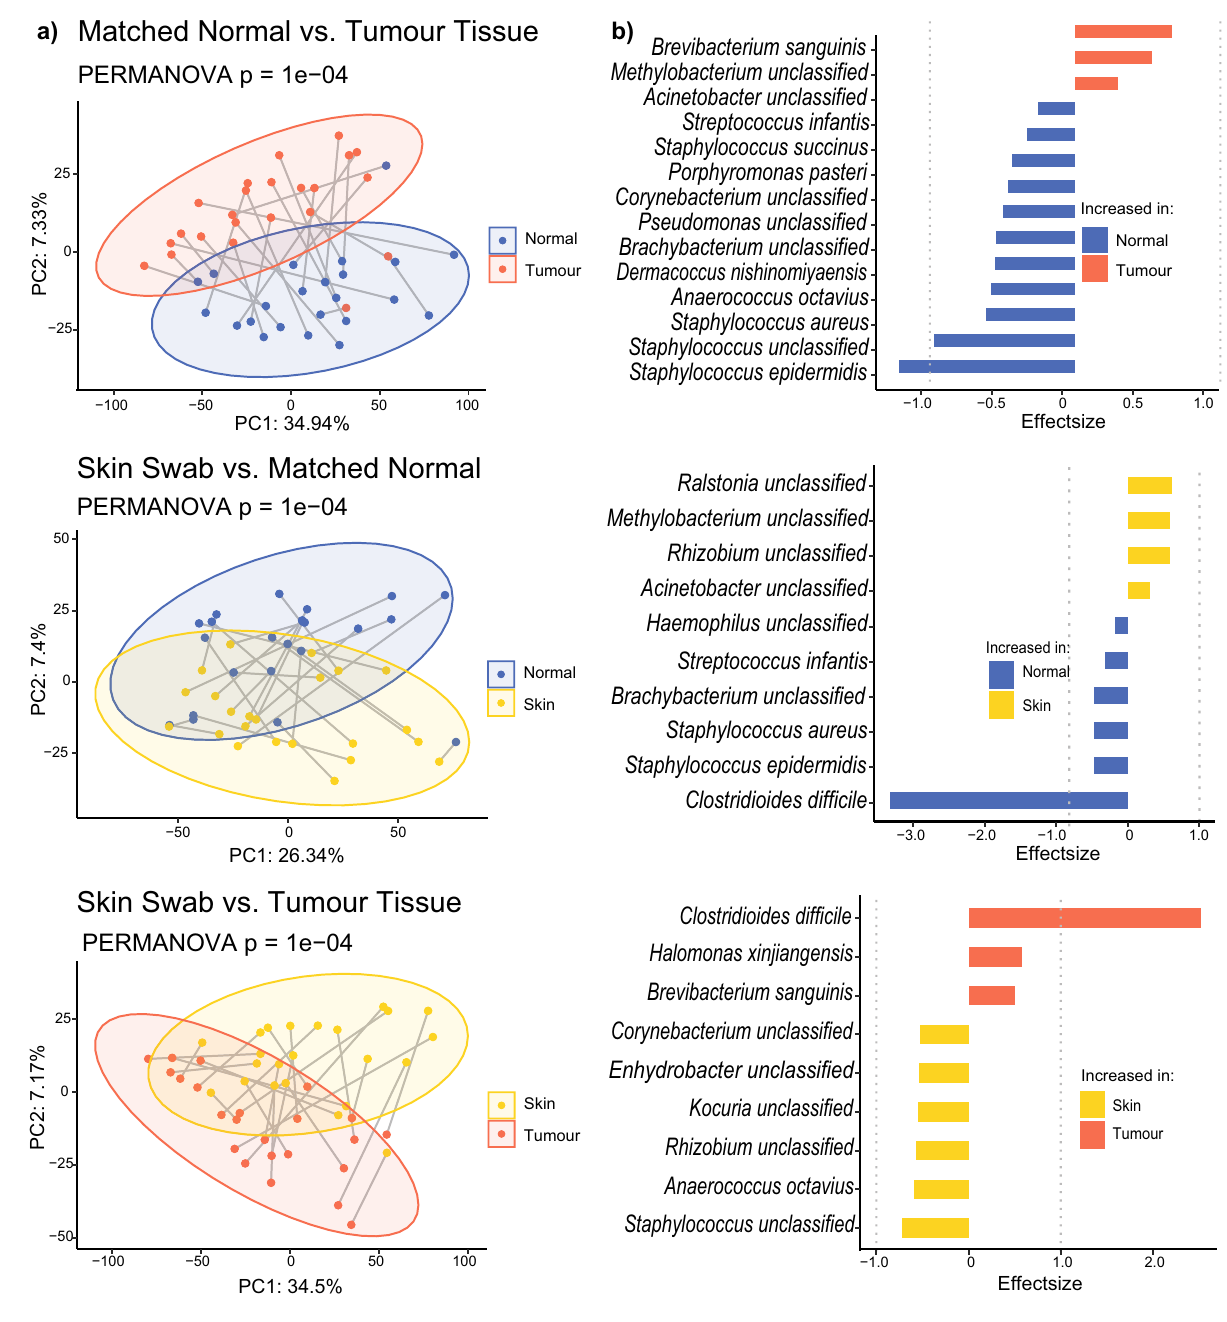
Figure 3. Microbiota composition in tumour and matched normal tissues and skins swabs. (a) Principal component analysis, based on Aitchison distances, of all bacterial species that are present in at least 5% of samples. Paired samples are connected by grey lines. ( b) Differentially abundant taxa with an adjusted p-value of less than 0.05. Effect size is defined as the between-group differences divided by the within-group